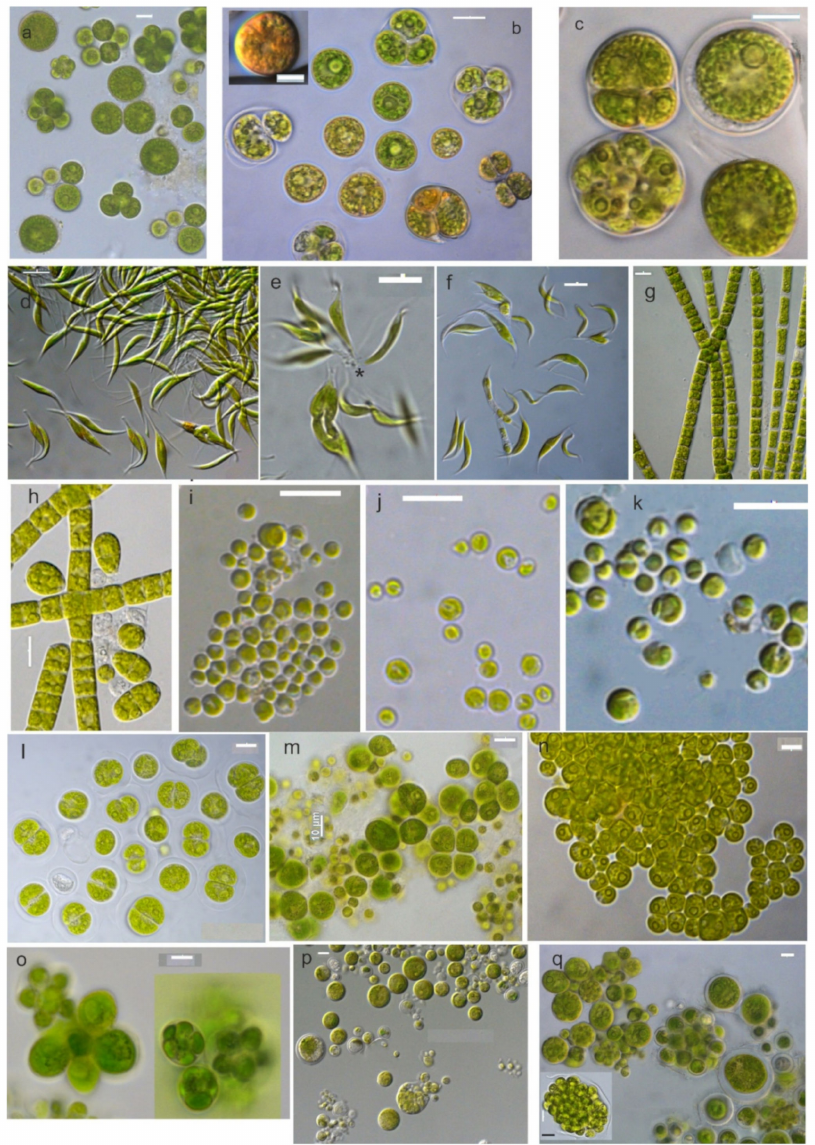
Figure 6. Light micrographs of strains Asterarcys quadricellulare TAU-MAC 3917 ( a – c ), Monoraphidium sp. TAU-MAC 1210 ( d – f ), Uronema trentonense TAU-MAC 0215 ( g , h ), Ava limnothalassea TAU-MAC 2217 ( i , j ), Nomia picochloropsia TAU-MAC 3617 ( k ), Spongiosarcinopsis limneus TAU-MAC 3310 ( l , m ), Lilaea pamvotia TAU-MAC 3510 ( n , o ), Akraea chliaropsychia TAU-MAC 0515 ( p , q ); ( a – c ): solitary cells, colonies of randomly arranged cells (arrow), autosporangia (arrowheads) and accumulation of pigments that were detected by color change (asterisk) (insert in ( b )). ( d – f ): several different cell shapes, lunate to sigmoid, narrow or acute at the ends, arched or curved. Asterisks indicate the colonies’ formation by one end attached in mucilage. Autosporangia (arrowhead) and mother cell division into two daughter cells (arrow). ( g , h ): filaments and young cells (arrows) (see also [18]). ( i , j ): microscopic coccoid solitary cells. ( k ): coccoid young and mature cells, mother cell division into two daughter cells (asterisk). ( l , m ): young and mature cells arranged in dyad and tetrad aggregations (arrows). ( n , o ): mature vegetative cells form tight aggregations, colonies of randomly distributed cells (arrow), and aplanosporangia (asterisk). ( p , q ): young aplanosporia released from aplanosporangia (asterisk) (inset in ( q )), mature vegetative cells form colonies (arrow), mucilage envelope is observable in solitary mature cells (arrowhead). All images are with DIC optics except ( a , j , l , m , o ). Bars, 10 µ